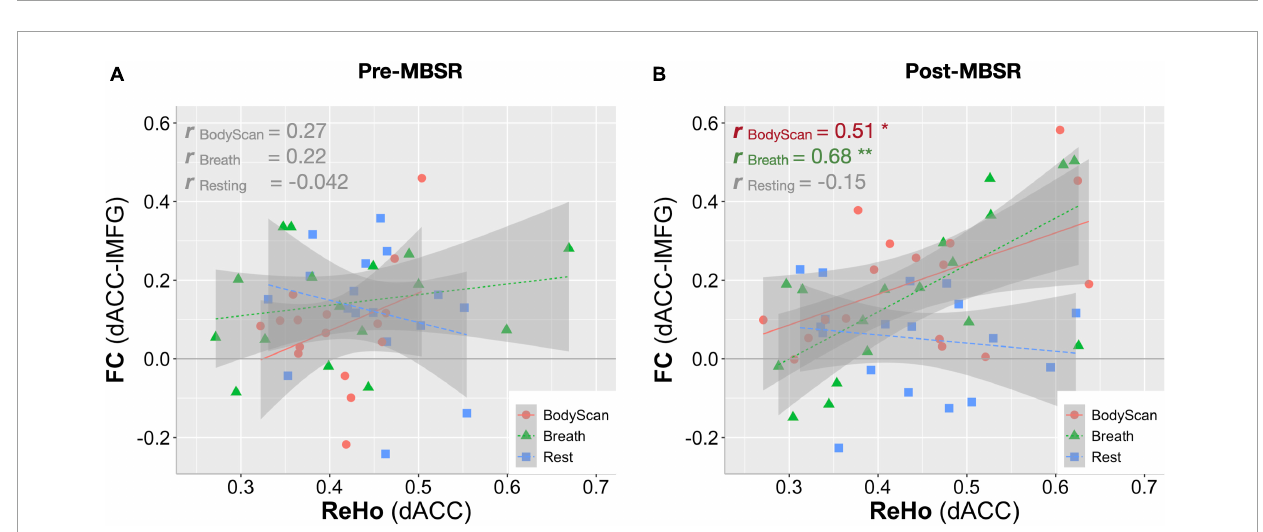
FIGURE4 Correlation analysis between FC and ReHo for the left middle frontal gyrus in each of the 3 conditions (Rest, Breath and BodyScan) of the MBSR group. (A) Before the MBSR training, no significant FC-ReHo relationship was observed. (B) After the MBSR training, post-intervention FC dACC exhibited a positive relationship with ReHo during both the breathing and the body scan, indicating a changed pattern of information processing in the salience